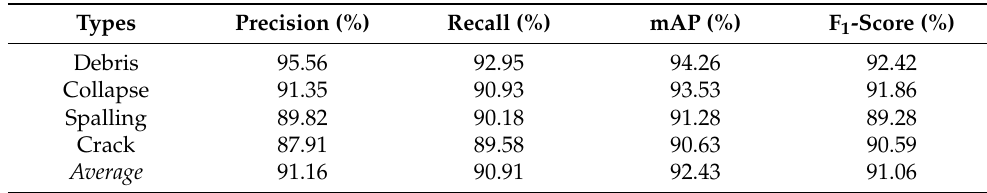
Table 2. Identification result of different damage types.